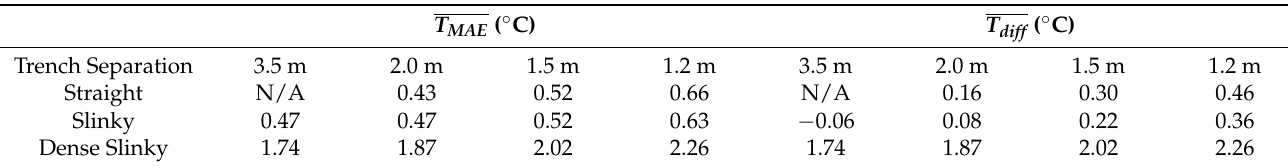
Table 4. T MAE and T dif f values for difference configurations and trench separations (using the straight pipe configuration with a 3.5 m separation as reference data).